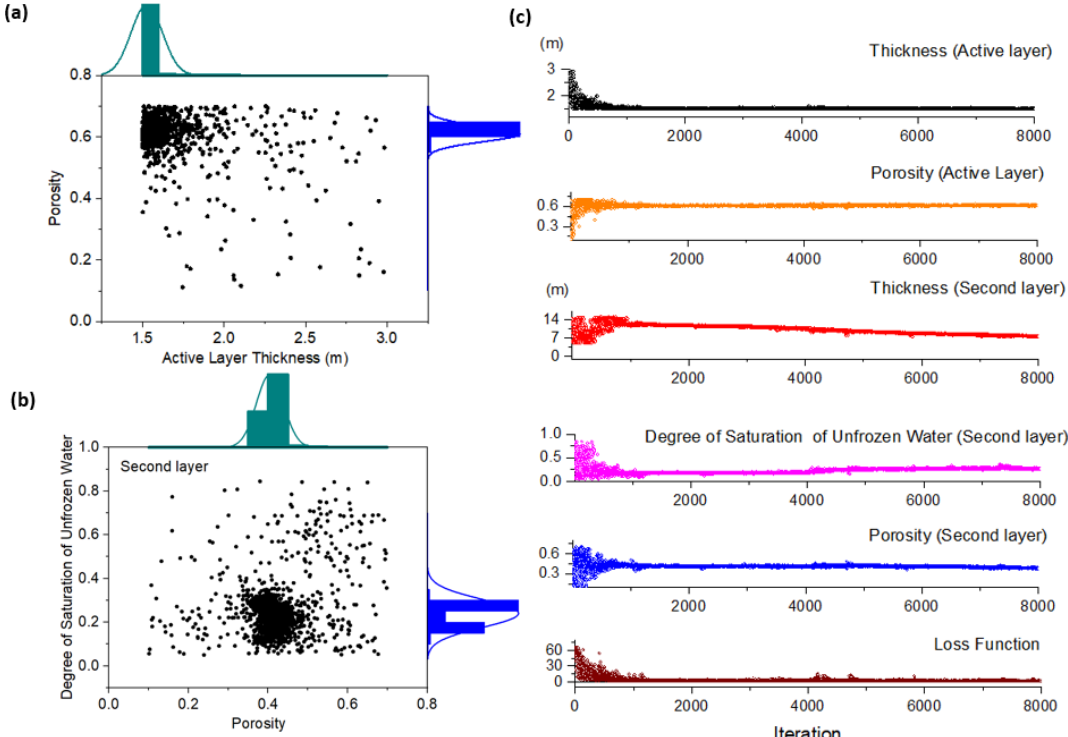
Figure 5. Inversion process for the R2 wave dispersion relation. (a) Sampling subspace between the degree of saturation of unfrozen water and the thickness of the active layer. (b) Sampling subspace between the degree of saturation of unfrozen water and the thickness of the permafrost layer. (c) Updates of thicknesses of the active layer and permafrost layer, as well as the physical properties in each layer by means of the neighborhood